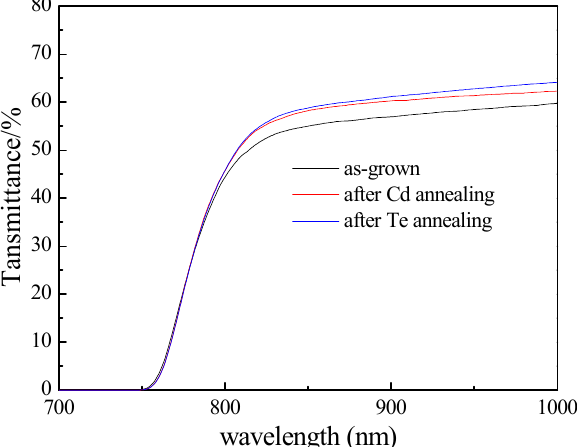
Figure 1. The typical near-infrared spectrum (NIR) transmittance spectra of CMT:In crystals before and after annealing (Cd atmosphere 1073K/240 h, Te atmosphere 773 K/120 h).